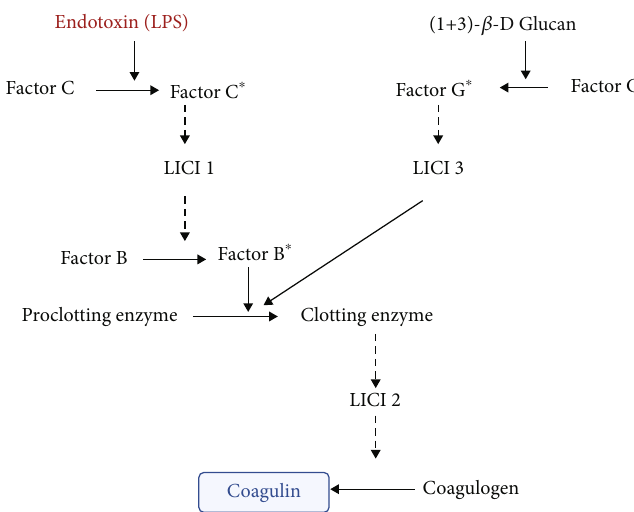
Figure 4: Cascade of horseshoe crab coagulation by coagulation inhibitors LICI-1, LICI-2, and